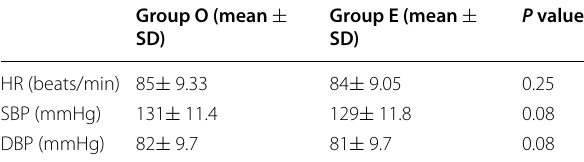
Table 2 Hemodynamic parameters of the two groups